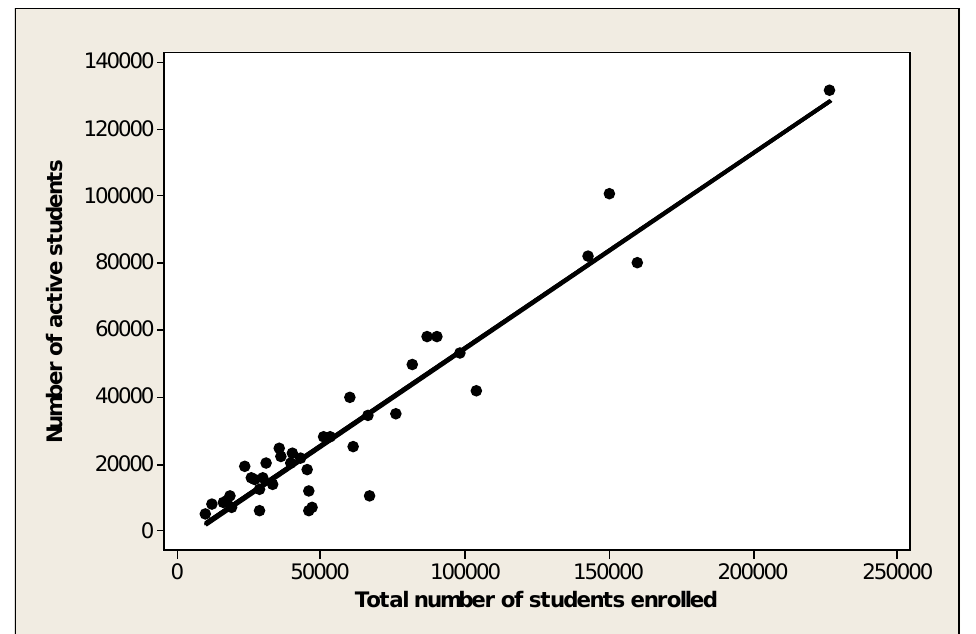
Figure 6 . Scatterplot of number of active students plotted against total enrolment for the sampled courses ( n =